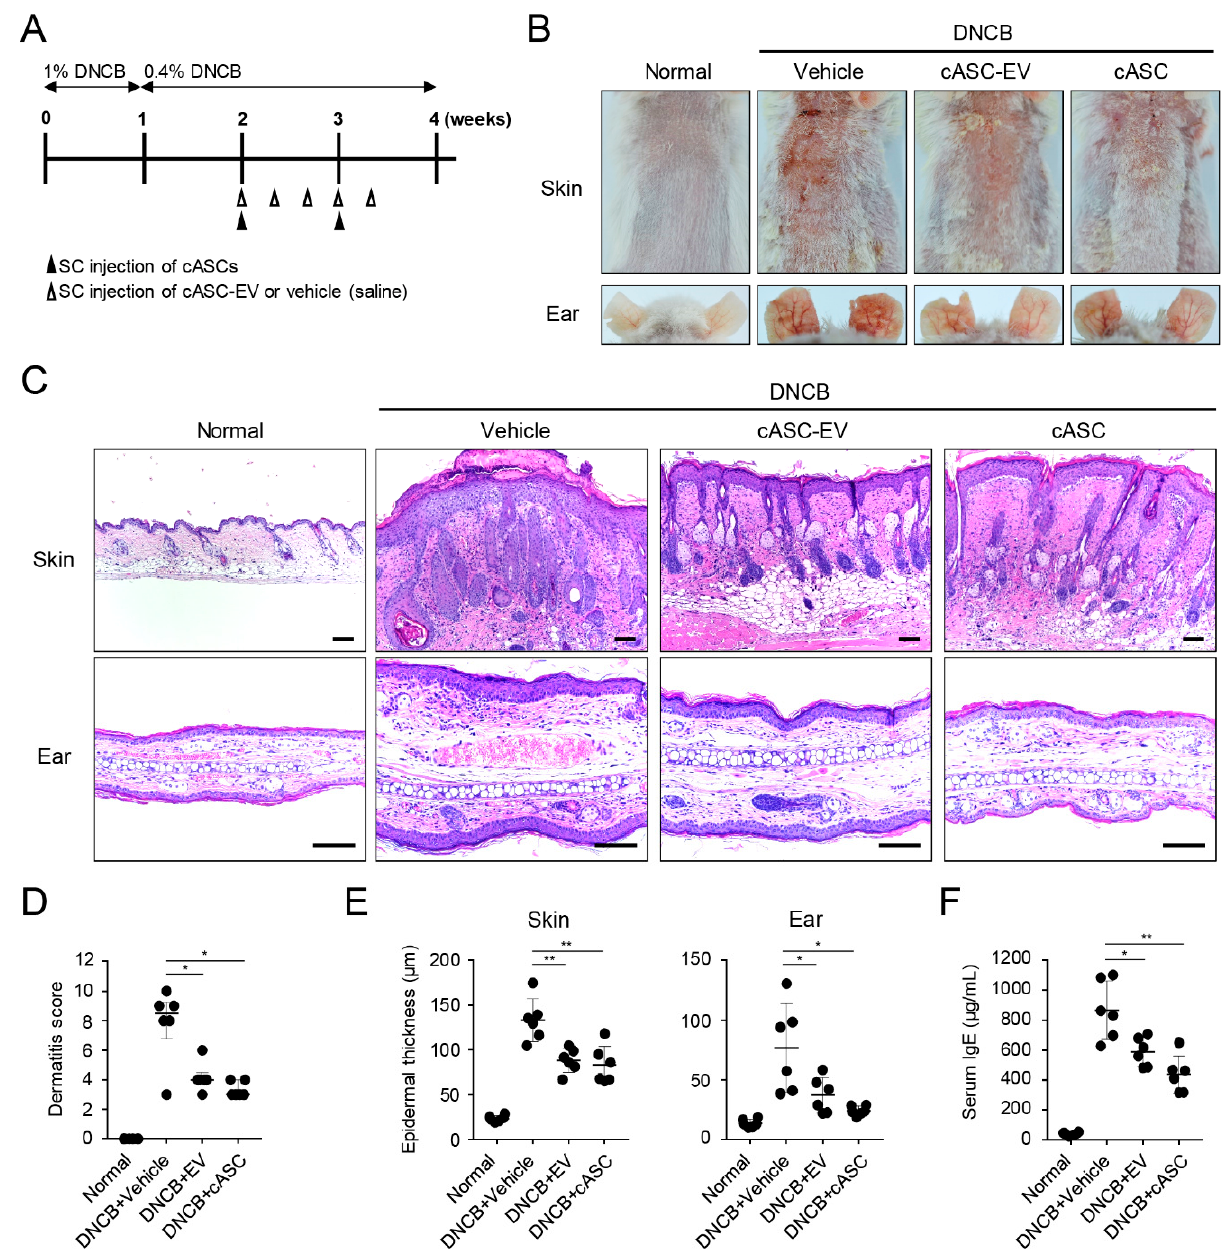
Figure 2. cASC and cASC-EV improve DNCB-induced atopic dermatitis-like skin lesion in Balb/c mice. ( A ) Schematic diagram for development of atopic dermatitis model by topical application of DNCB in Balb/c mice. After mice were sensitized with DNCB for 7 days, DNCB was further topically applied to the shaved dorsal skin and ear for 3 weeks. cASC was applied twice and cASC-EV was applied 5 times for 2 weeks ( n = 6/group). ( B ) Representative dorsal skin and ear photographs of each treatment group showing comparison of AD-like skin lesions. ( C ) Tissue sections from the back skin and ear stained with hematoxylin and eosin (H&E). Scale bar, 100 μ m. ( D ) The severity of dermatitis evaluated by a 3-point scoring index of atopic dermatitis. Dermatitis score was graded as 0 (absent), 1 (mild), 2 (moderate), or 3 (severe) based on the sum of the scores of clinical signs such as excoriation/erosion, scaling/dryness, edema, and erythema/hemorrhage. ( E ) Epidermal thickness of back skin and ear ( n = 6/group). ( F ) The concentration of the serum total IgE levels measured by an ELISA. Dermatitis score represent median [IQR] (min–max) and the others represent mean ± SD. Significant value was * p < 0.05, ** p < 0.01 vs. DNCB + Vehicle.